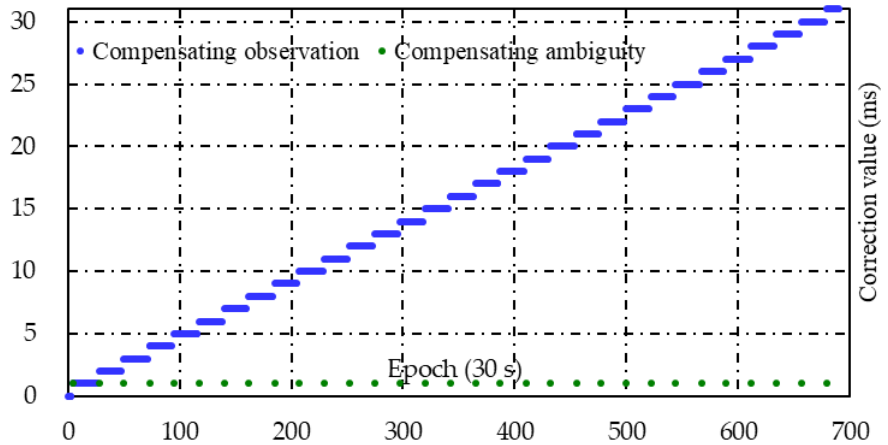
Figure 3. Corresponding ms correction to L1 of G24 on DOY 133, 2008, with respect to Figure 2 with traditional and new methods.